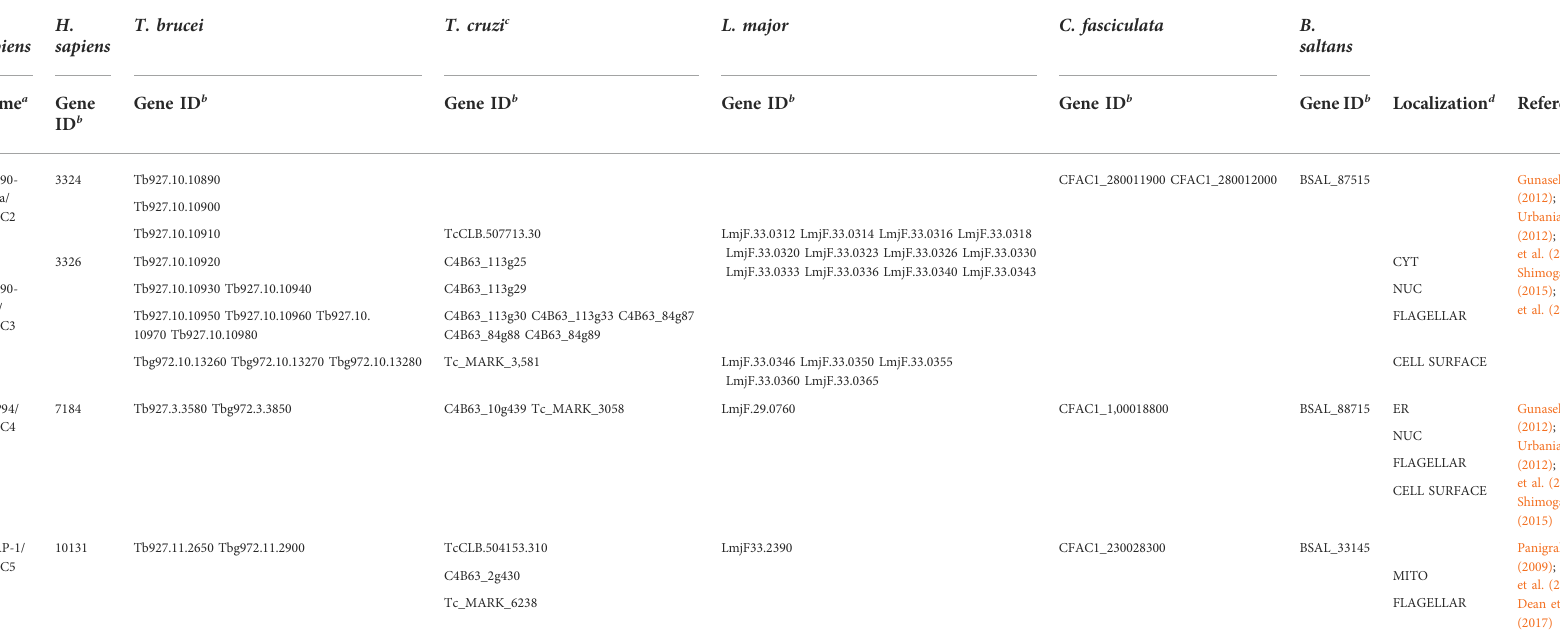
TABLE 1 HSP90/HSPC proteins from Trypanosoma brucei with putative orthologues in T. cruzi , L. major , C. fasciculata , B. saltans , and H. sapiens . H. H. T. sapiens sapiens